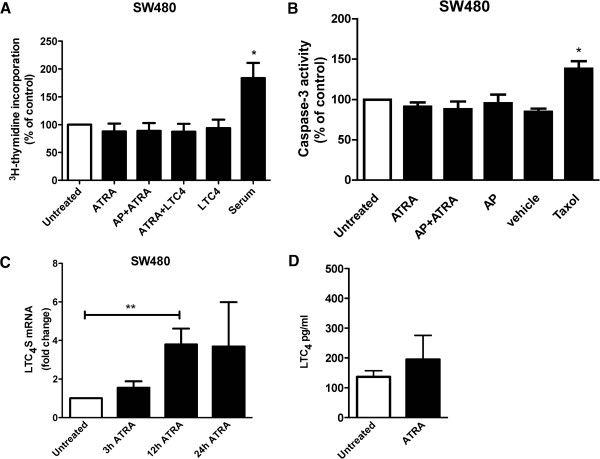
FLuc cells plated at range of concentration from 5 × 10 cells/well to from 1 × 106cells/well, treated with 30 mg/ml D-Luciferin at 1:200 dilution and Imaged using IVIS machine. Shows highest intensity of light at the concentration of 1 × 105cells/well. Results were measured (mean ± sd).